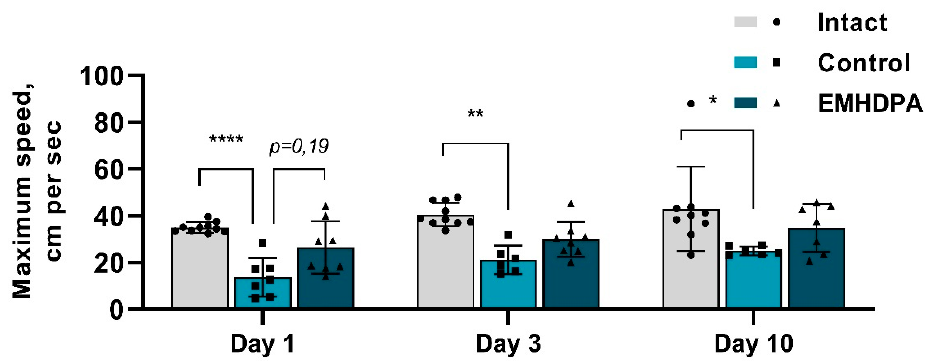
Figure 7. The effect of the studied drugs on the maximum speed in the actimetry test. Note: *— p < 0.05; **— p < 0.01; ****— p < 0.0001; 1—intact group; 2—control group; 3—group administered with EMHDPA 25 mg/kg.